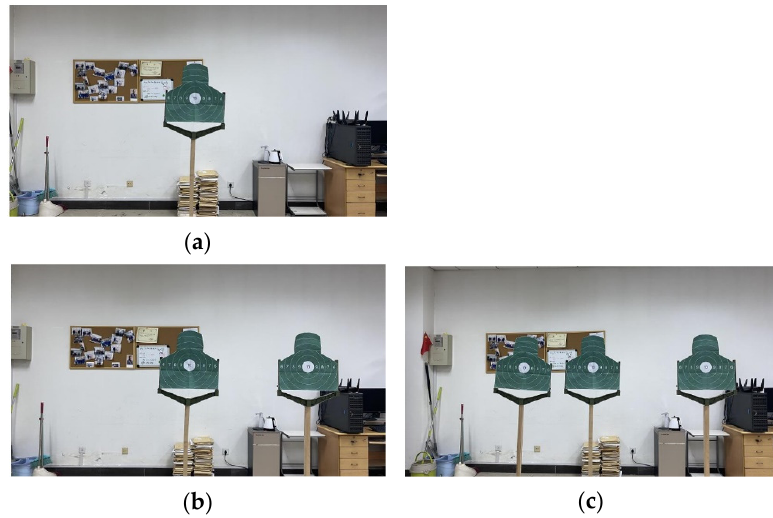
Figure 17. Test scene of the target center gaze. ( a ). Gazing target; ( b ). Interference target; ( c ). Interference target.